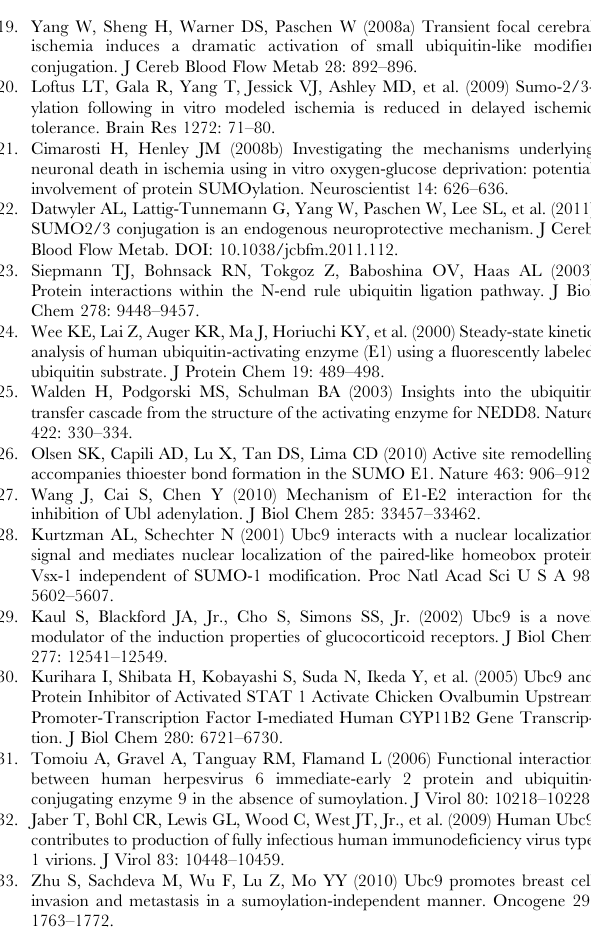
with astrocytes and oligodendrocytes exhibiting low expression levels of this protein. (TIF) Figure S2 SUMO-1 and SUMO-2,3 conjugation levels in the brain from WT and Ubc9 transgenic mice with and without MCAO. Representative immunoblots of whole SUMO- 1 and SUMO-2,3 protein patterns in the brain extracts from the WT and transgenic mice without MCAO surgery (A) or that had been subjected to 24 h pMCAO (B). The top panels show Ubc9 levels and the bottom panels show actin levels. (TIF) Figure S3 Distribution of neuronal cells in a whole coronal section of WT and Ubc9 transgenic (H3) mice that had been subjected to 24 h pMCAO. NeuN (green), a pan-neuronal marker; parvalbumin (purple), a marker for interneurons. (TIF) Figure S4 Distribution and intensity of SUMO-1 (con- jugated and free form) in a whole coronal section of WT and Ubc9 transgenic (H3) mice that had been subjected to 24 h pMCAO. (TIF) Figure S5 Distribution and intensity of SUMO-2,3 (conjugated and free form) in a whole coronal section